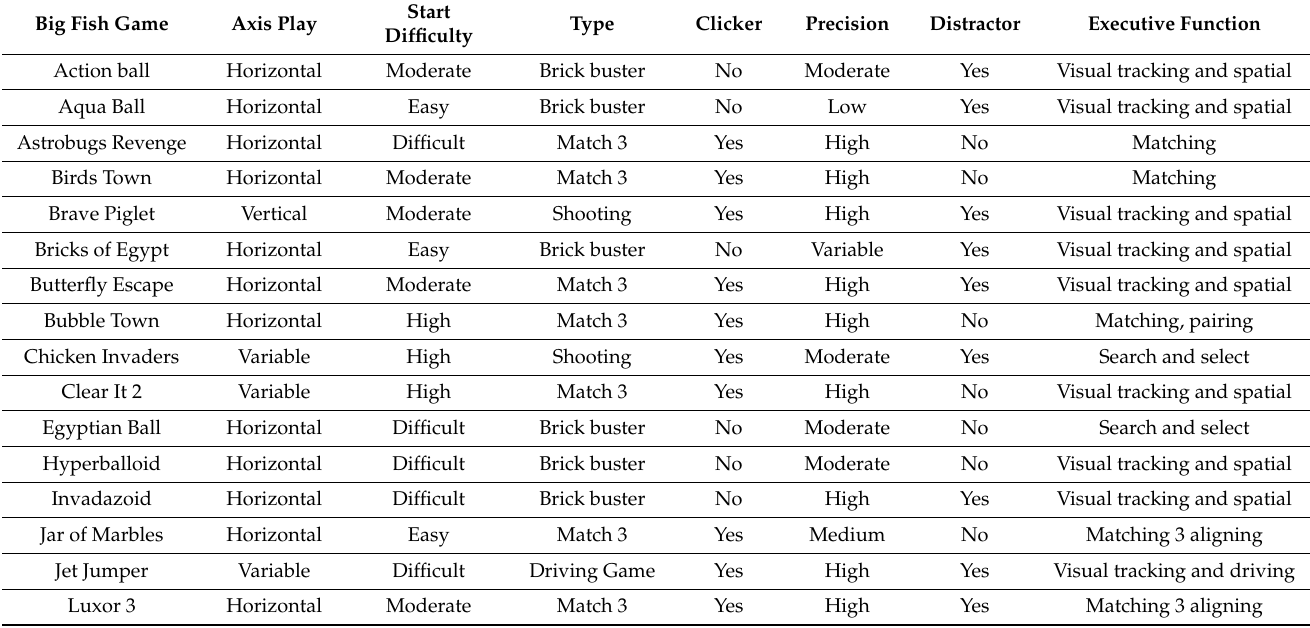
Table A1. Example computer games downloaded from www.Bigfishgames.com (accessed on 1 August 2021) and used for the experimental exercise programs. Note that matching and shooting games require children to utilize a small wireless optical computer mouse with a left-mouse button to press when